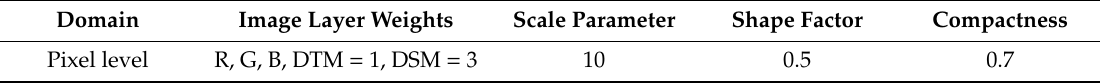
Table 1. Parameters of the multiresolution segmentation